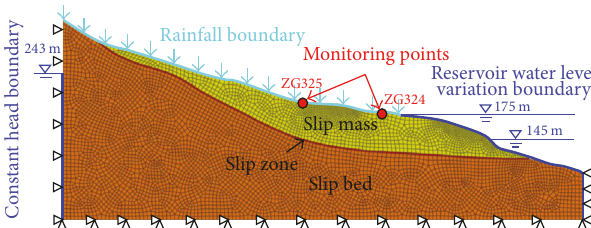
Figure 5: The finite element model of the landslide, with mesh and boundary conditions.